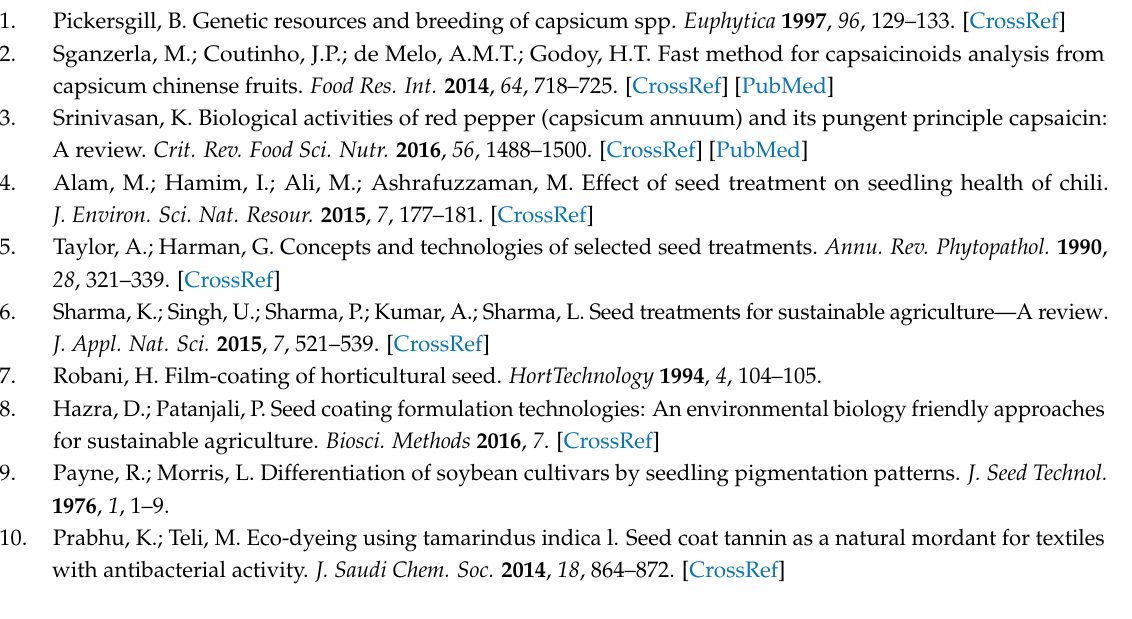
Supplementary Materials: The following are available online at http://www.mdpi.com/1424-8220/18/8/2500/ s1, Table S1: Normalized Intensity observed at different depths for all seeds in C. annum group (control), Table S2: Normalized Intensity observed at different depths for all seeds in C. annuum cv. PR Ppareum group, Table S3: Normalized Intensity observed at different depths for all seeds in C. annuum cv. PR Yeol group, Table S4: Normalized Intensity observed at different depths for all seeds in C. annuum cv. Asia Jeombo